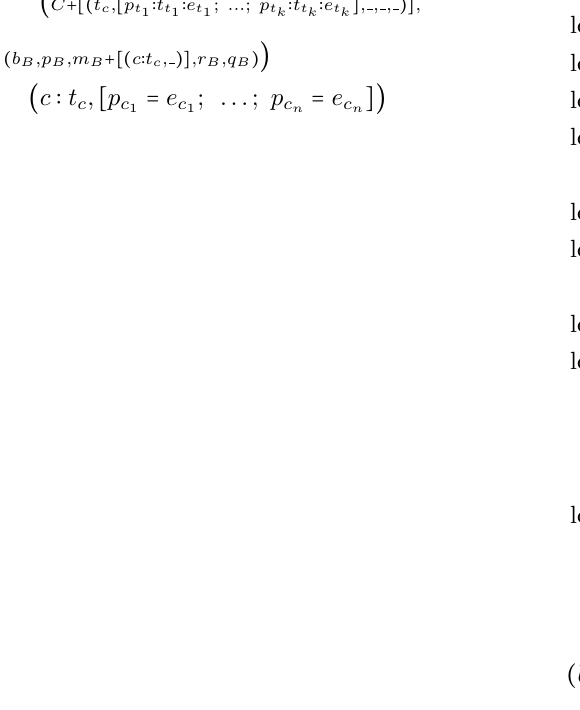
Figure 20: Function NBm—Normalize component modifications. All parameters from the modified component are extracted from the component’s block definition and are introduced as fresh (decorated) parame- ters in the block enclosing the component declaration. During that introduction it is ensured that the components modification replace the parameter modifications from the component’s block